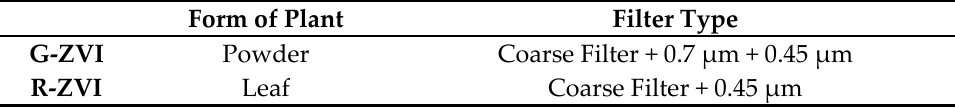
Table 2. Best extract type and filtration method according to UV/Vis spectrum of the